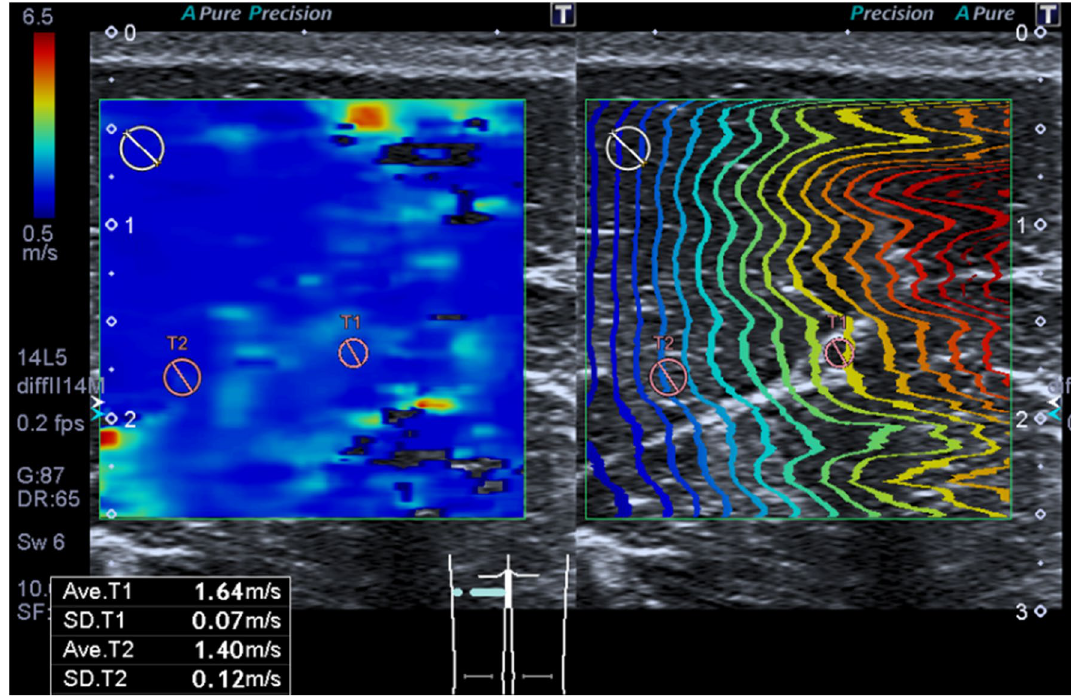
Figure 2. Images of the sciatic nerve and biceps femoris muscle of a dog in the speed mode of shear wave elastography. The images for the speed mode are the shear wave velocity (m/s) map ( left image ) and the map for the propagation mode ( right image ). Note that consistent parallel contour lines are shown in the propagation mode. Red circles of T1 (2 mm in diameter) and T2 (diameter: 4 mm) indicate the ROIs of the sciatic nerve and biceps femoris muscle,